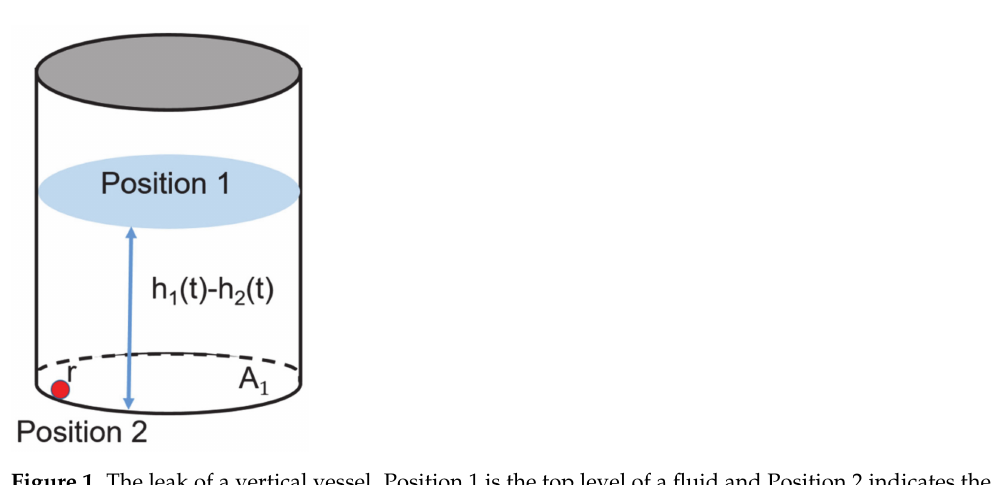
Figure 1. The leak of a vertical vessel. Position 1 is the top level of a fluid and Position 2 indicates the leak at the bottom of the vessel. The cross sectional area of the fluid is A 1 and the red circle is the leak hole with a radius r